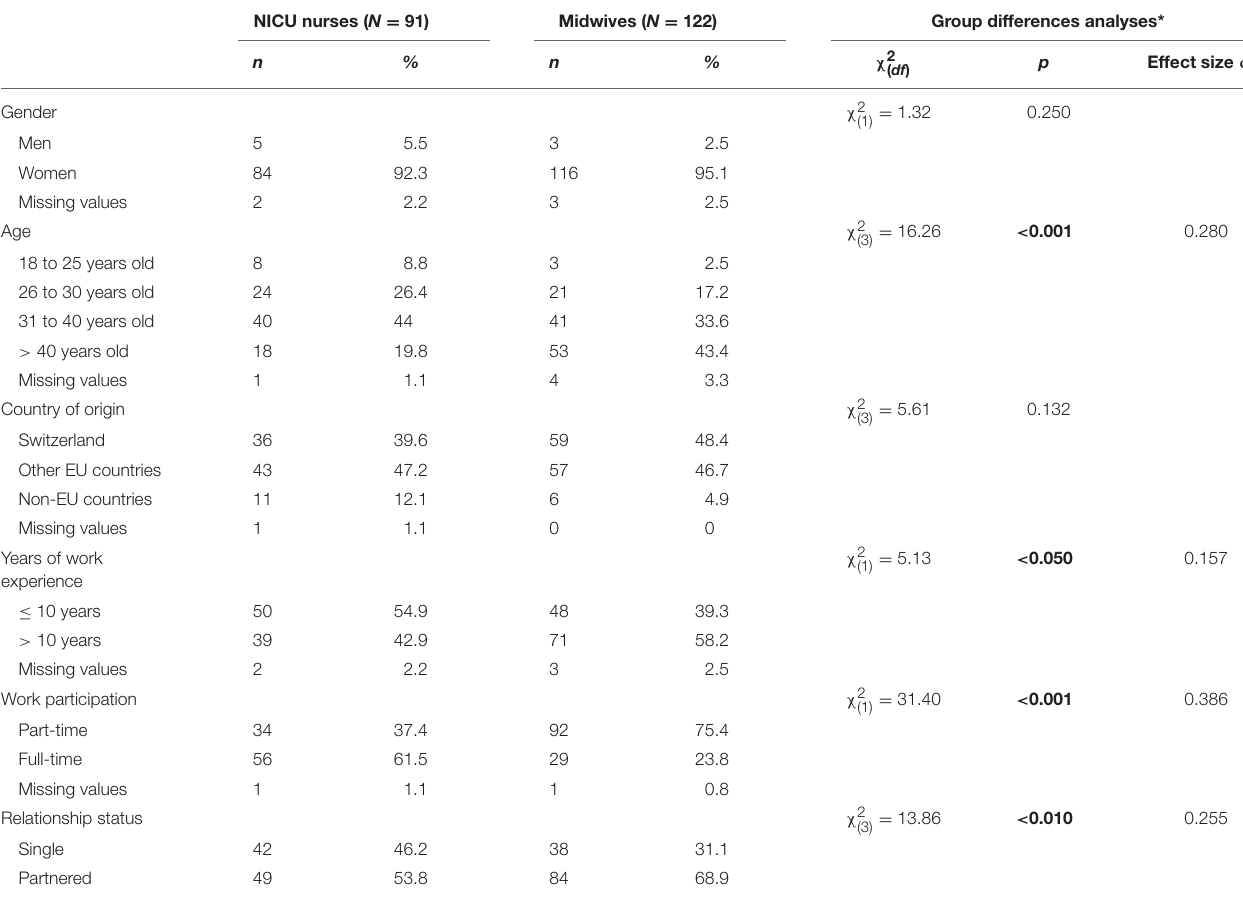
TABLE 1 | Demographic sample characteristics and group